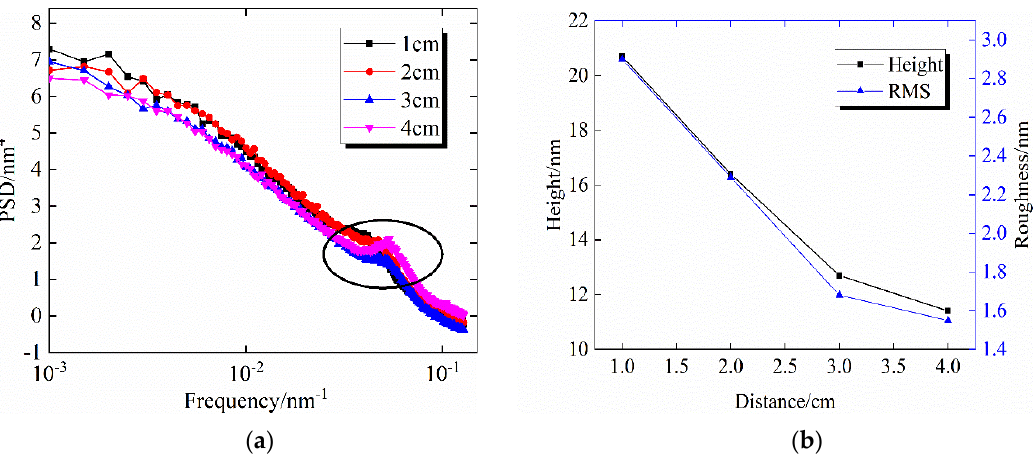
Figure 7. Curves of PSD, RMS, and Height of the sample surface with the distance of impurity target. ( a ) PSD curve; ( b ) RMS, Height curve.